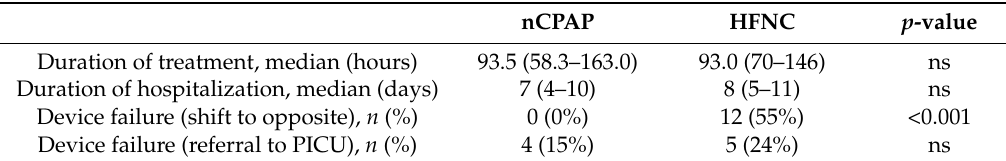
Table 2. Duration of treatment, hospital stay and system failure.